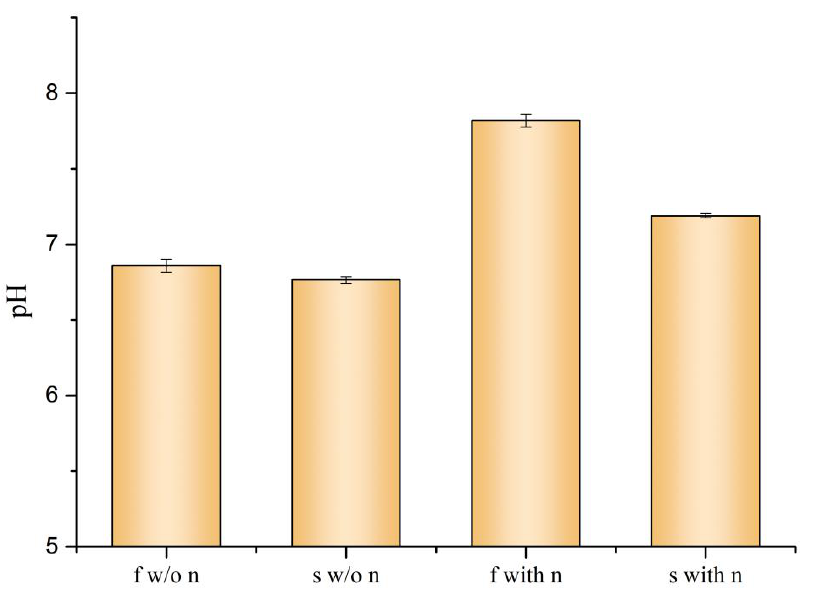
Figure 5. The pH values in different systems on the 14th day (f w/o n: full system without nitrate addition, s w/o n: starvation system without nitrate addition, f with n: full system with nitrate addition, and s with n: starvation system with nitrate addition).